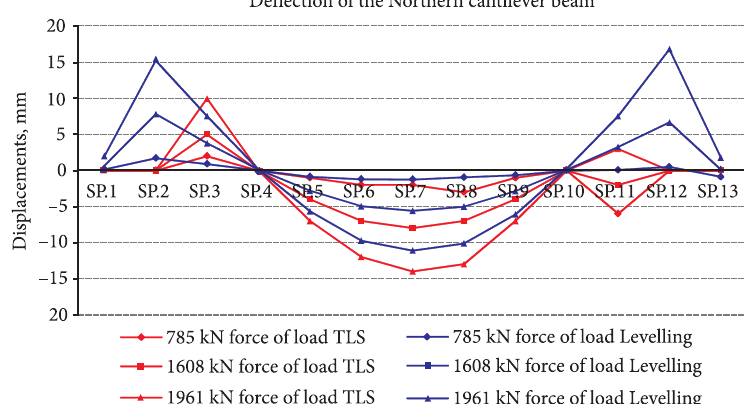
Fig. 11. Comparison of TLS and levelling results of the Northern beam. Note: at the centre of the beam (SP.7) deflection difference between TLS and levelling is under 785 kN –0.177 cm; under 1608 kN –0.24 cm; under 1961 kN –0.289 cm Table 3. Comparison of deformation